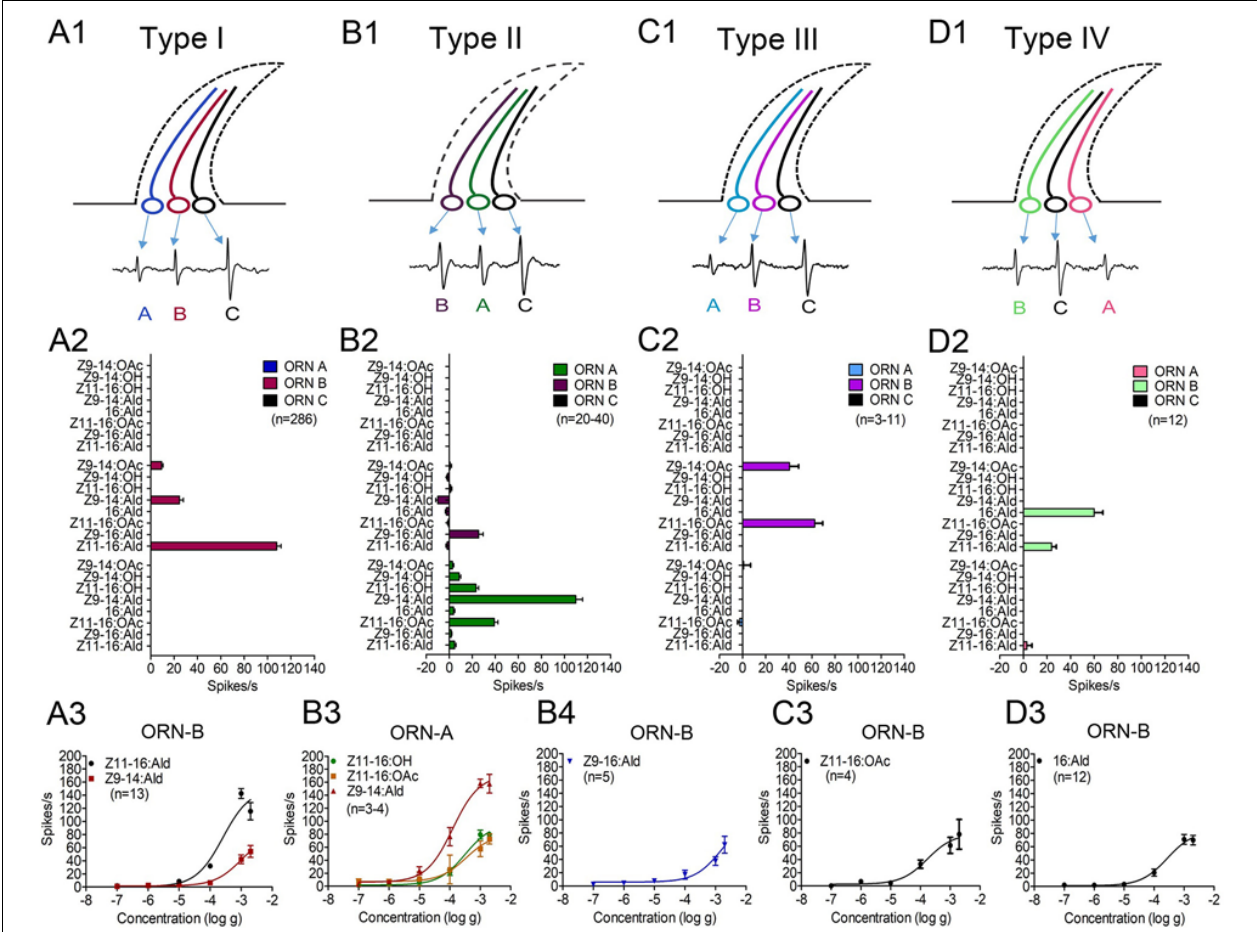
FIGURE 3 | Response profiles of three distinct ORNs (-A, -B, -C) and dose-response curves of functional ORNs housed in four types of TS (type I, II, III, and IV) on the antennae of male M. separata in response to four sex pheromone components and four pheromone analogues. (A1,B1,C1,D1) Distinct ORNs housed in four types of TS. (A2,B2,C2,D2) Response profiles of distinct ORNs housed in four types of TS. The amount of each stimulus was 1 mg. The responses of ORN-B of type-I TS were 101 ± 2 spikes/s ( n = 286) for Z11–16:Ald and 27 ± 1 spikes/s ( n = 286) for Z9–14:Ald. The ORN-A of type-II TS was activated by Z9–14:Ald, Z11–16:OAc, Z11–16:OH, with responses of 110 ± 6 spikes/s ( n = 40), 39 ± 3 spikes/s ( n = 40), and 23 ± 2 spikes/s ( n = 40), respectively. Responses of ORN-B were 26 ± 4 spikes/s ( n = 40) for Z9–16:Ald. The ORN-B of type-III TS was activated by Z11–16:OAc and Z9–14:OAc with responses of 63 ± 7 spikes/s ( n = 11) and 41 ± 8 spikes/s ( n = 3), respectively. The ORN-B of type-IV TS was activated by 16:Ald and Z11–16:Ald with responses of 60 ± 7 spikes/s ( n = 12) and 24 ± 4 spikes/s ( n = 12). (A3,B3,B4,C3,D3) Dose-response curves of functional ORNs. The order of the neurons among sensilla types and color code were random. Error bars indicate mean ±